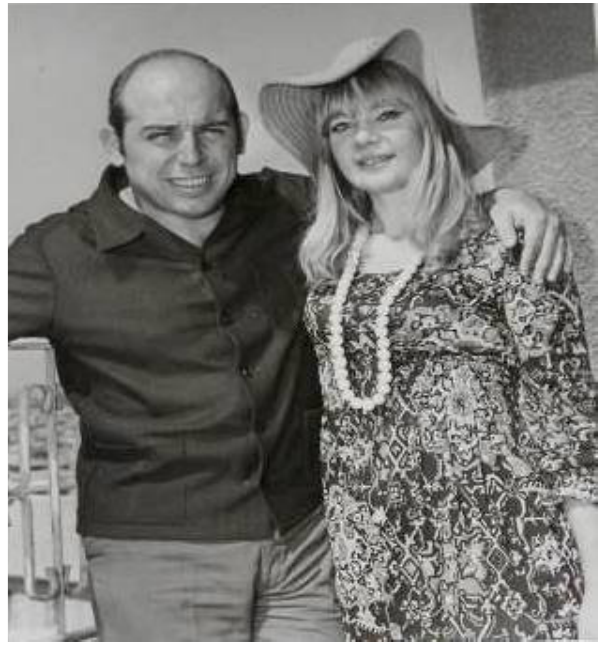
Figure 6: Eva Bender, the Swedish actress who played Eva in the film, was briefly married to the film's director, Halit Refi ğ in the 1960s (Anon.